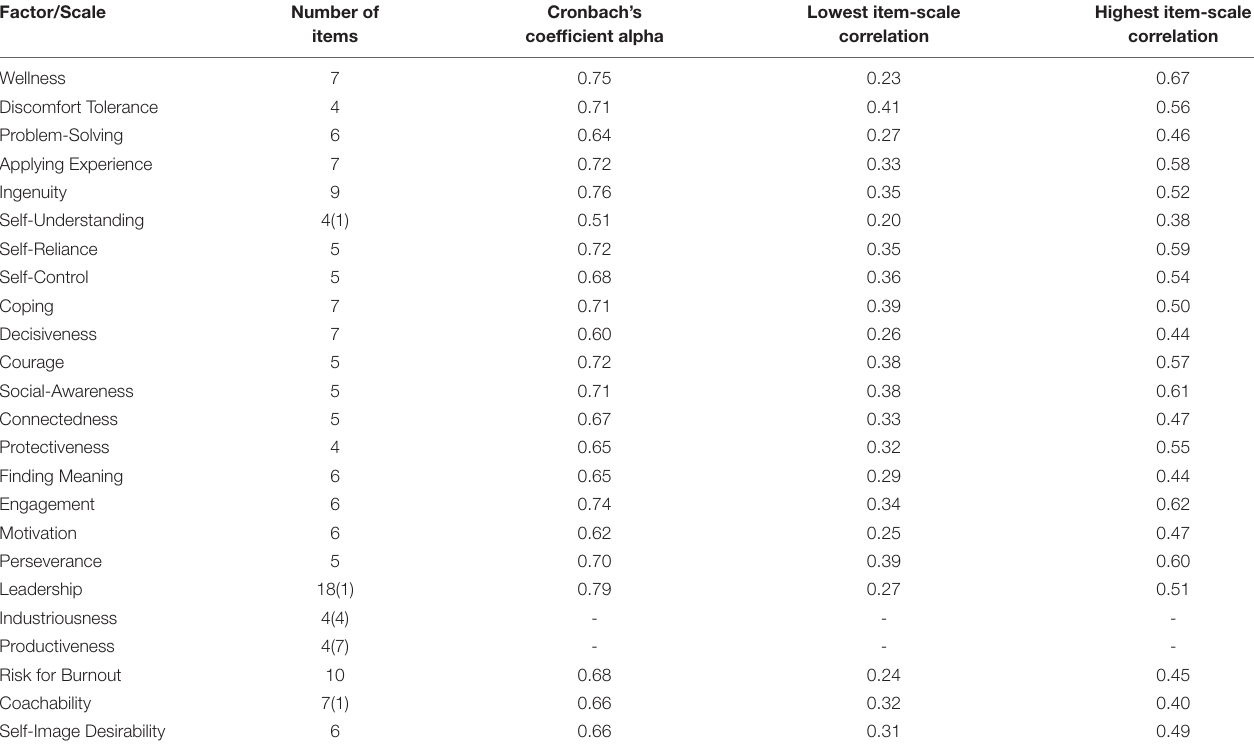
TABLE 4 | Internal consistency of the MMP scales ( n